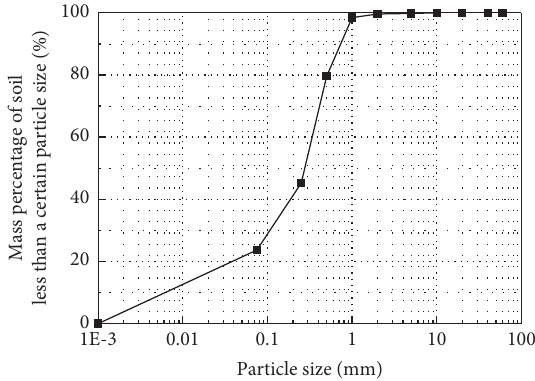
Figure 2: Particle size distribution of the tested